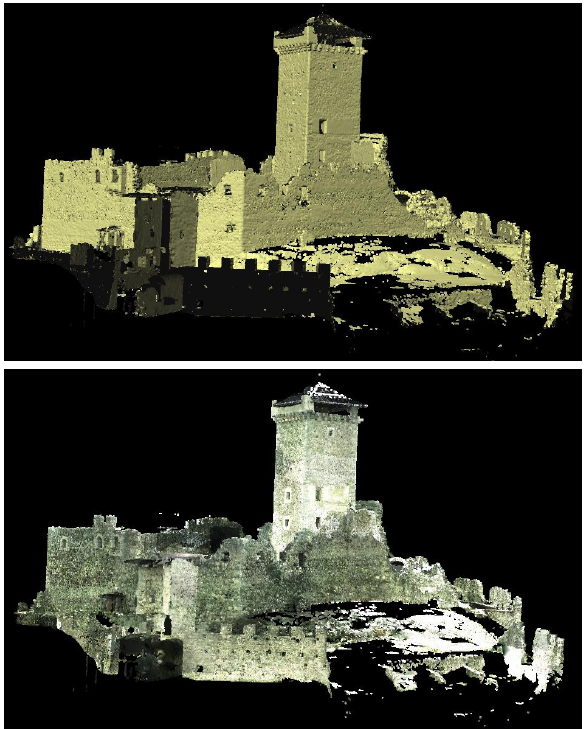
Figure 4: The complete 3D model of the heritage, visualized as shaded and colour mode.